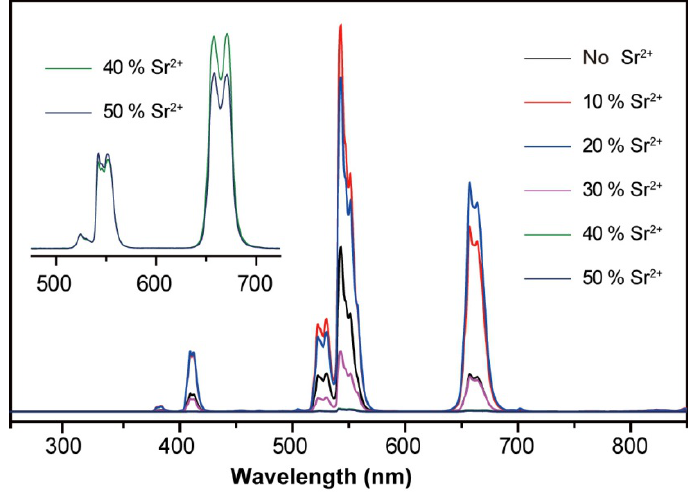
Figure 4. Upconversion emission spectra of the NaYF obtained in the presence of different amount of Sr 2+ dopant ions. Inset: amplified spectra of the nanoparticles comprising high dopant concentration of Sr 2+